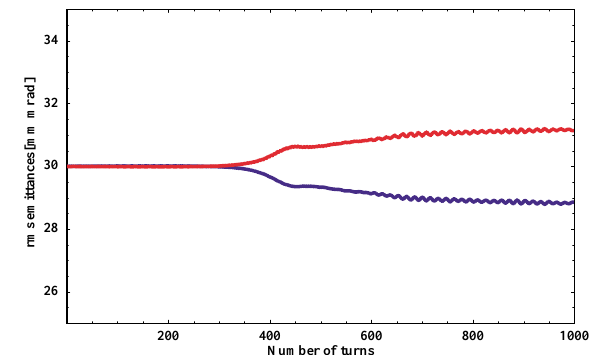
FIG. 3. (Color) Time evolution of rms emittance for (cid:1) n x , n y (cid:2) (cid:1) (cid:1) 5.82, 5.79 (cid:2) . X emittance is shown in blue and Y emittance in red.